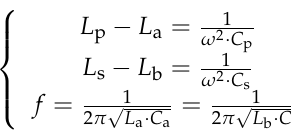
Figure 3. Fundamental harmonic model of double-sided LCC WPT system.